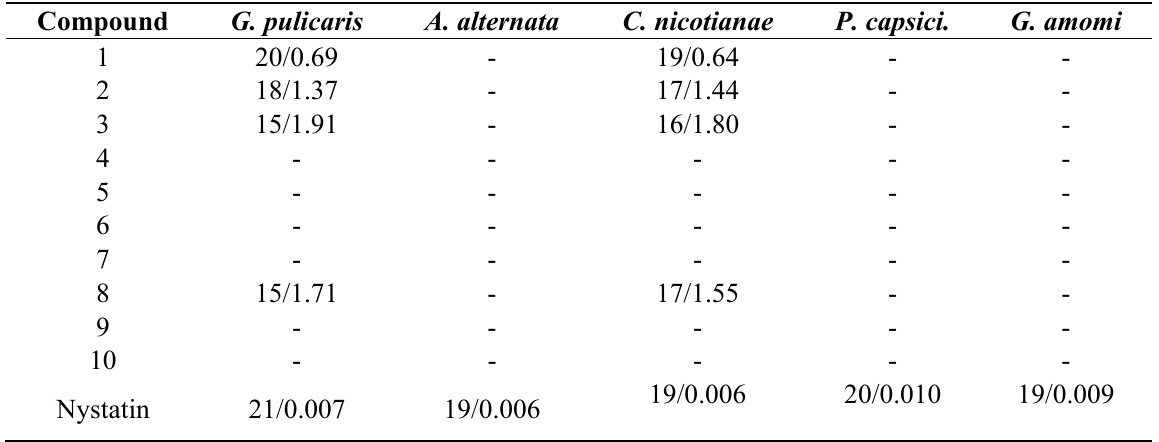
Table 4. Antifungal activities (zones of inhibition/and MIC mM, n = 3) of compounds 1 – 10 .